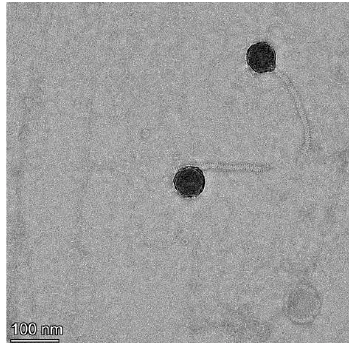
Figure 1. Transmission electron microscopy of V-YDF132. Scale bar represents 100 nm.